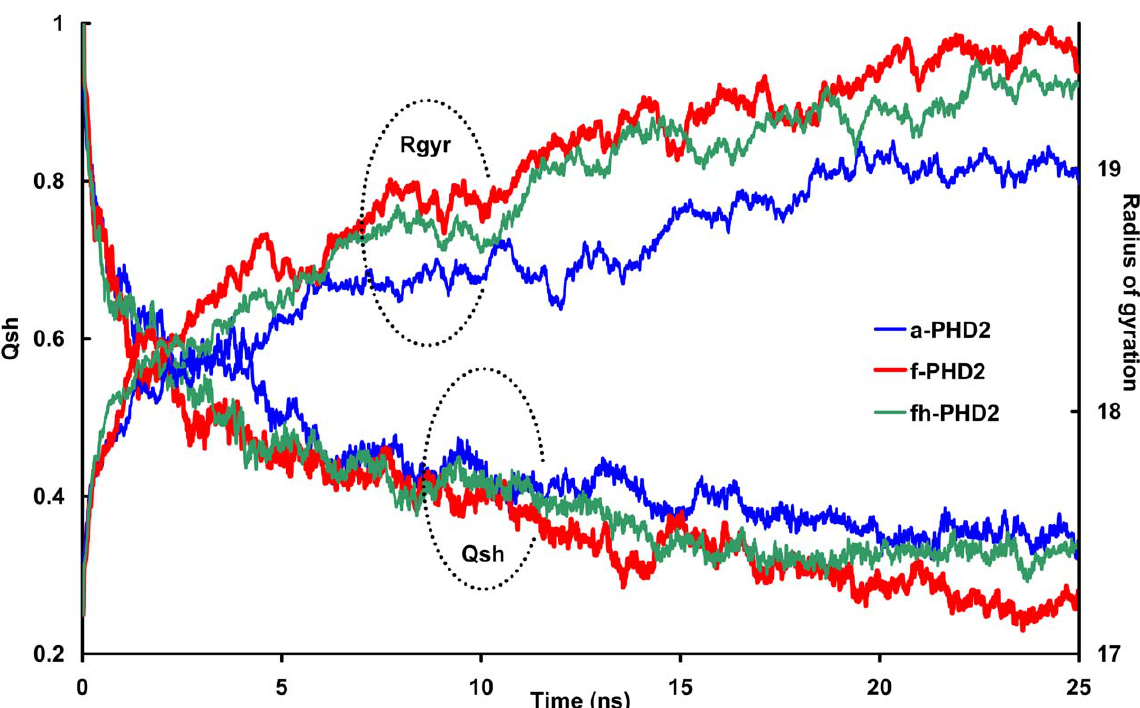
Figure 1. Representation of unfolding process metrics. The fluctuations of long range native contact fraction ( Qsh ) and radius of gyration as a function of simulation time are represented.